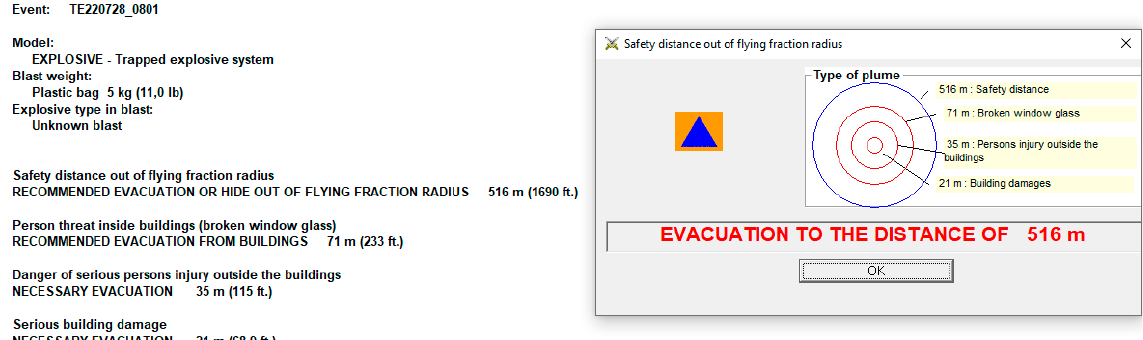
Figure 7. Initial information about the scope of the event.